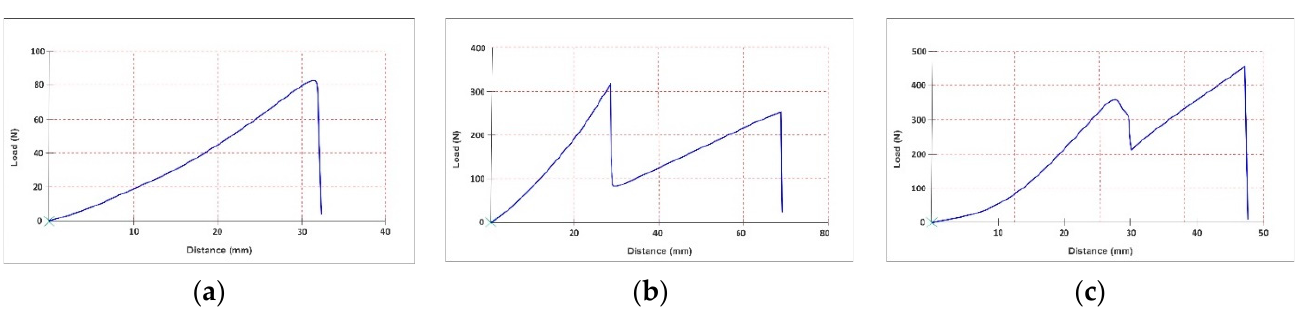
Figure 7. Tensile curve for stitched samples: ( a ) calfskin (M1); ( b ) calfskin with PES knitted fabric lining (M1 + M2); and ( c ) calfskin with sheep leather lining (M1 + M3).